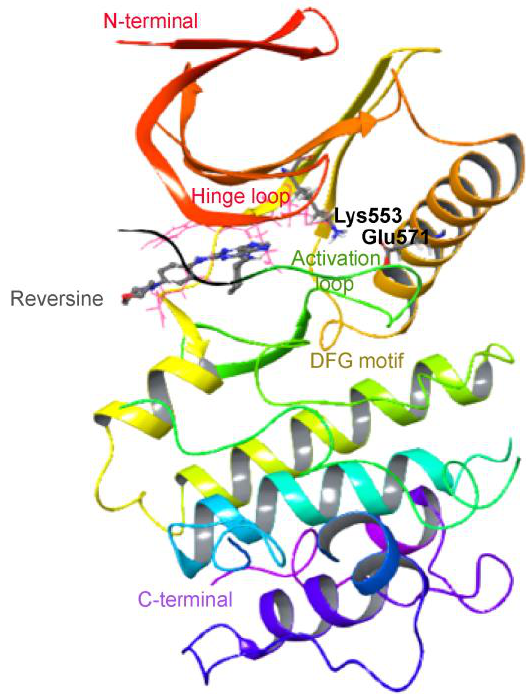
Figure 1. Structure of Mps1 kinase domain (PDB ID 5ljj). In human Mps1, the activation loop is defined by residues Gln672 to Lys680 and